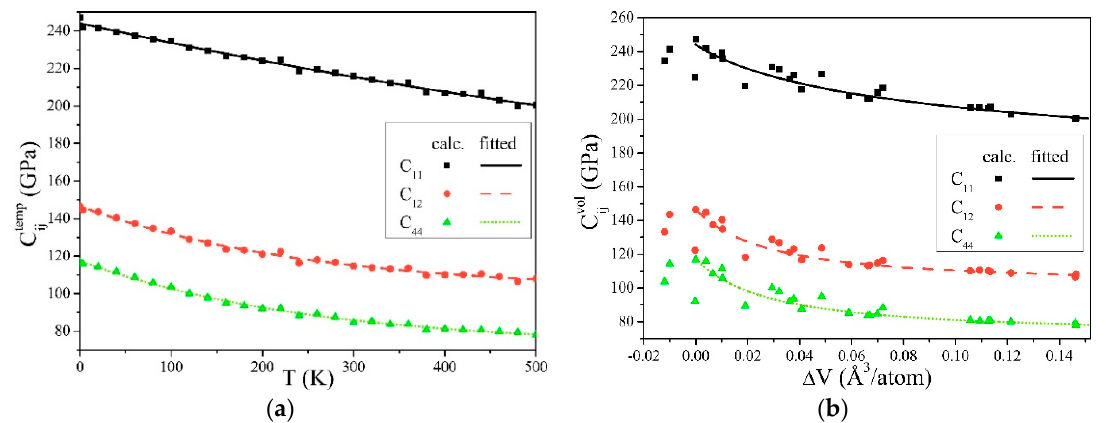
Figure 1. Elastic constants of α -Fe, influenced by ( a ) the temperatures, and ( b ) the changes of volumes.